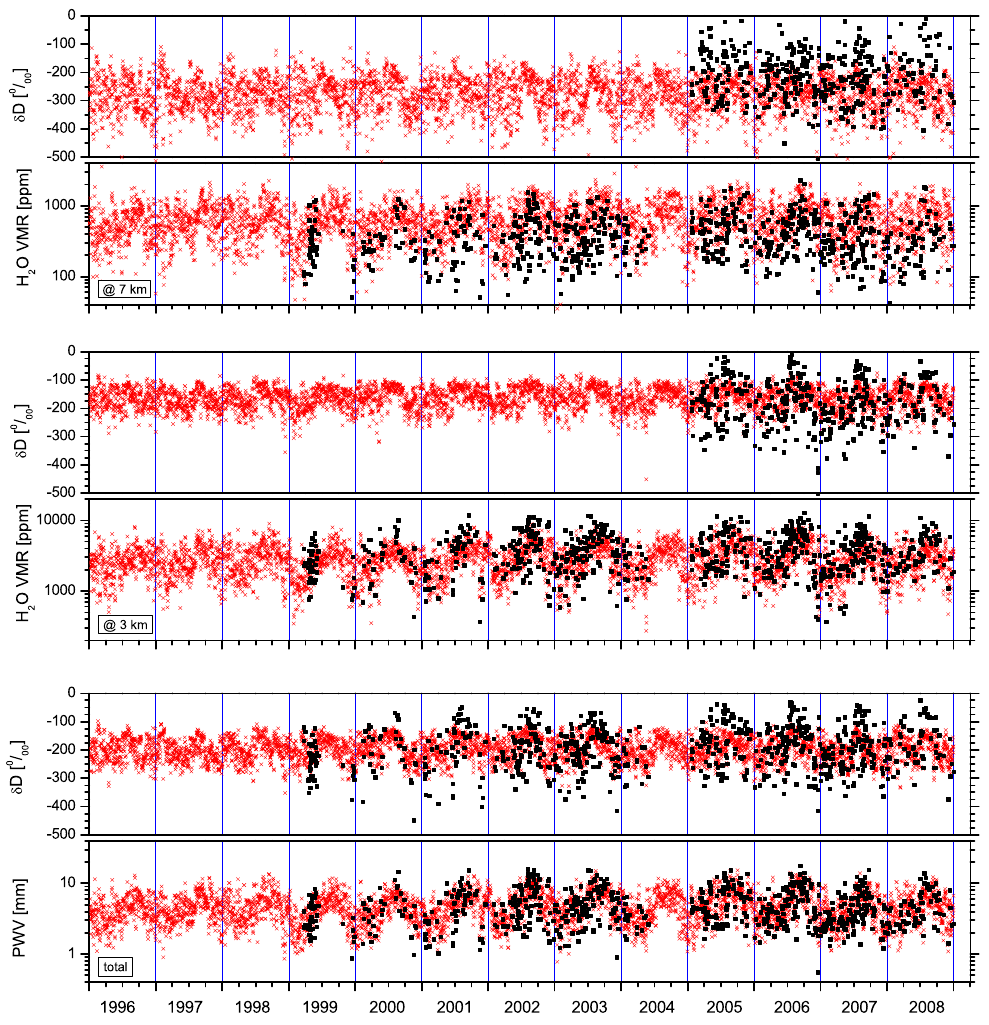
Fig. 2. Same as Fig. 1, but for Iza˜na and the column integrated atmosphere, the lower free troposphere (at 3km), and the middle troposphere (at